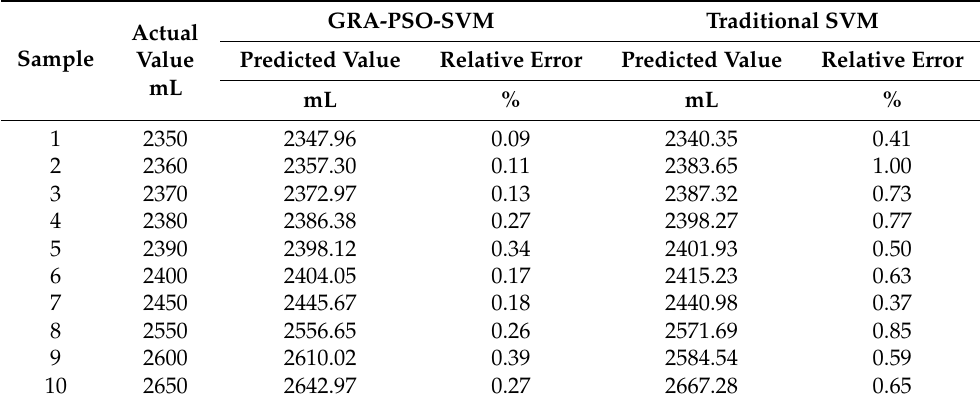
Table 3. Simulation results from three